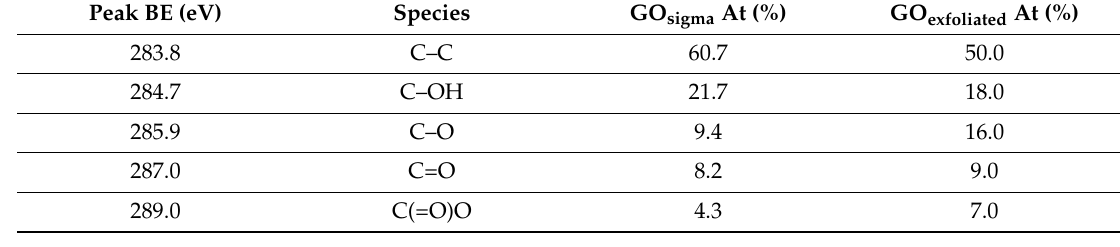
Table 2. Atomic (At) percentages from C1s fit for GO sigma and GO exfoliated .